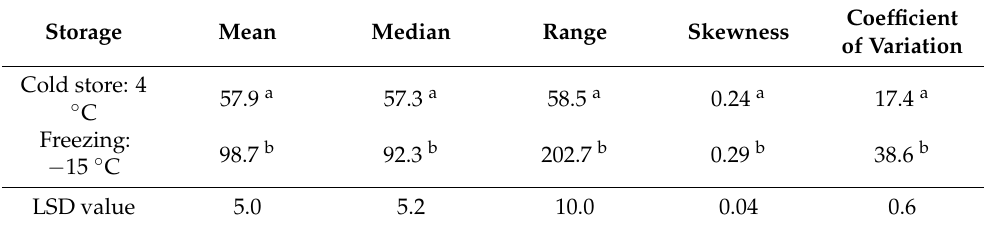
Coefficient of Variation